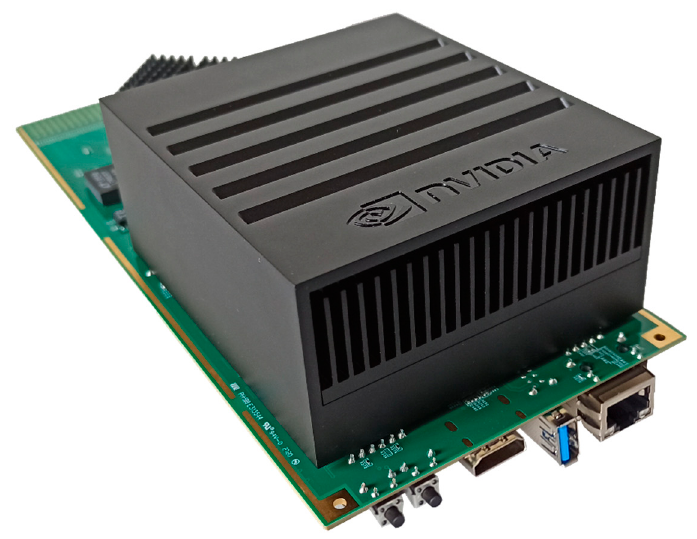
Figure 4. Isometric view of the expansion board. In the foreground, the Jetson module installed on the custom board, with HDMI, USB and gigabit Ethernet connectors.